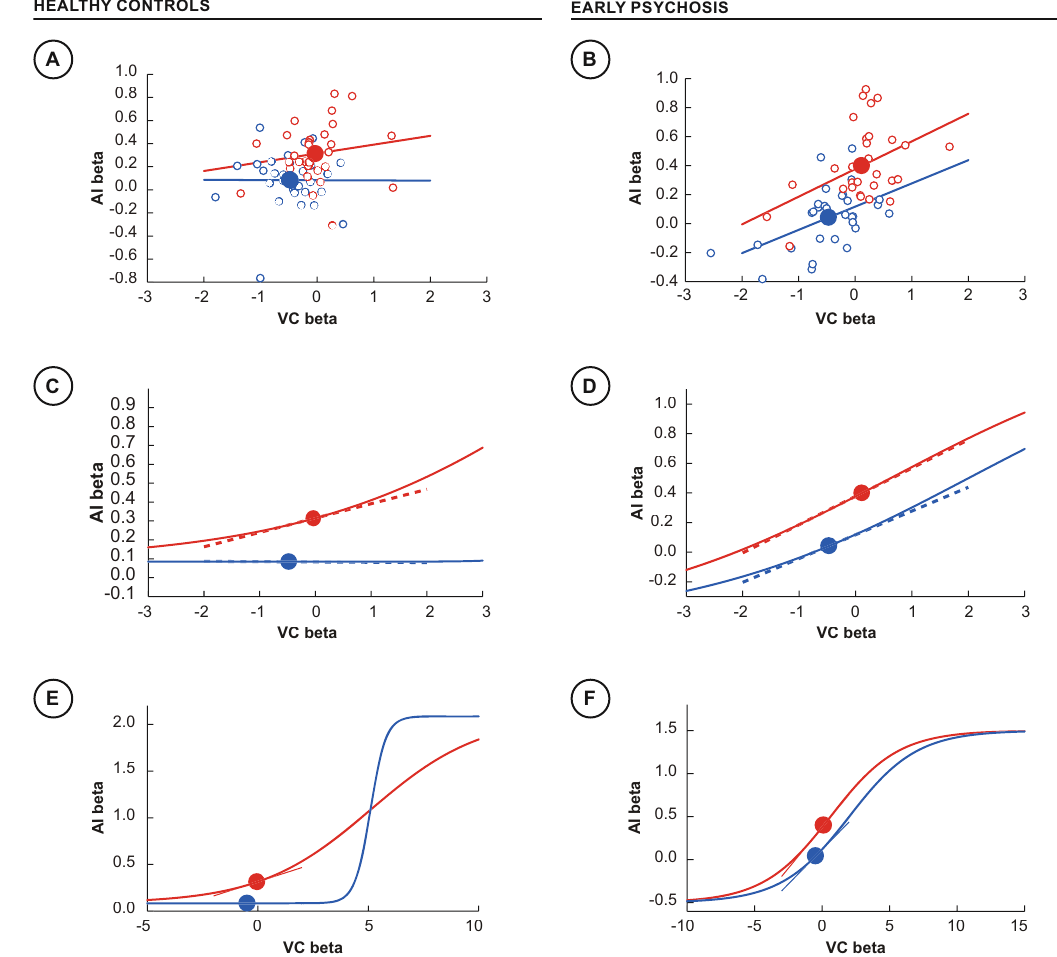
Fig. 5 Gain control. Gain-mediated relationships between stimulus responses in the visual cortex (inputs, x axes) and task responses in the AI (outputs, y axes) using beta estimates extracted from interference > baseline and neutral > baseline t-contrasts. Top row A , B shows parameter estimates extracted from SPM contrasts in VC and AI for neutral (blue lines) and interference (red lines) conditions, with line of best fi t across participants. Middle and lower rows show local ( C , D ) and global ( E , F ) sigmoid-shaped activation functions, whose local tangents yield the state-dependent input-output gain